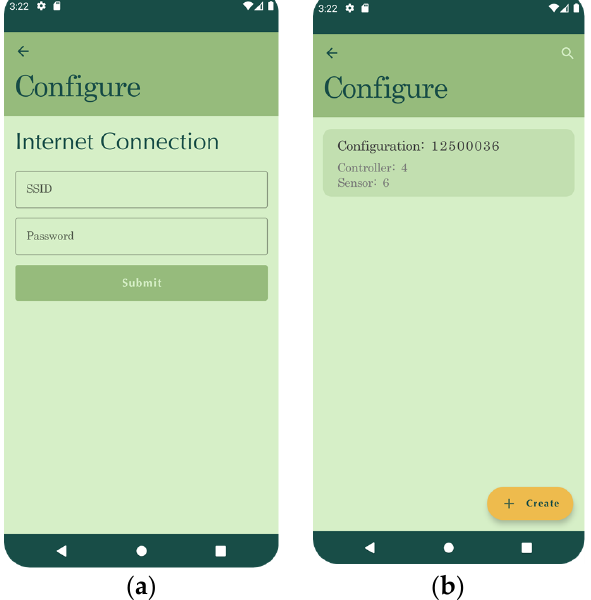
Figure 7. Configuration screens: ( a ) Wi-Fi configuration screen; ( b ) sensing node configuration screen.